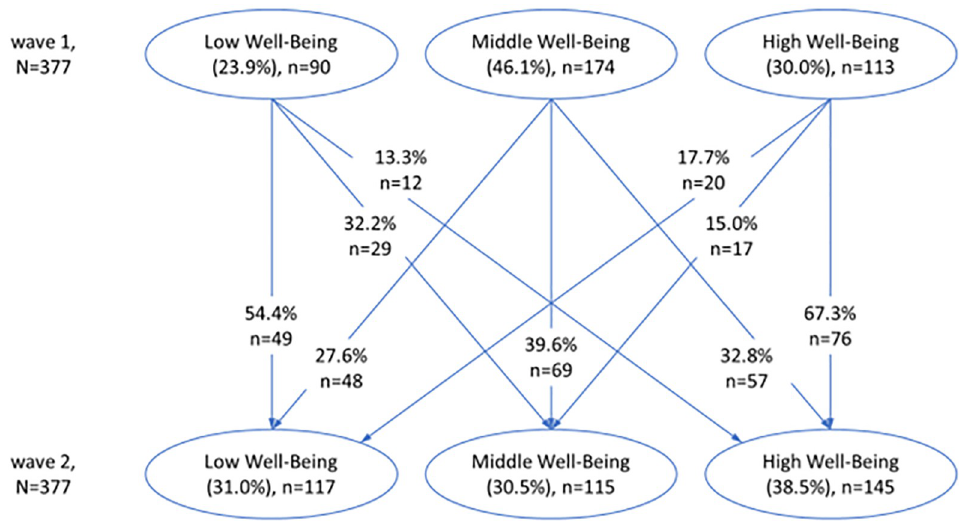
Fig 3. Transition over time among different patterns of well-being levels N = 377 participants followed-up, in parentheses, estimates of status membership probabilities.